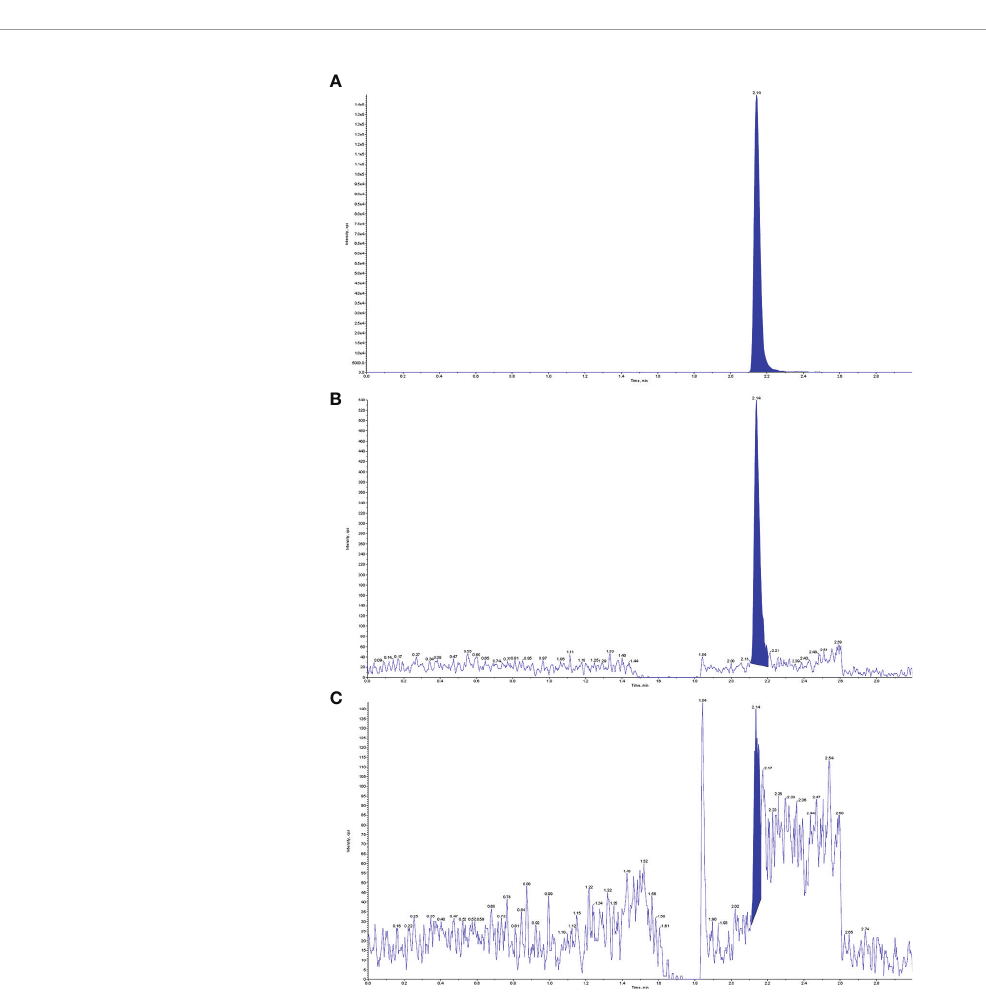
FIGURE 2 | Trends of APL cells counts in CSF.